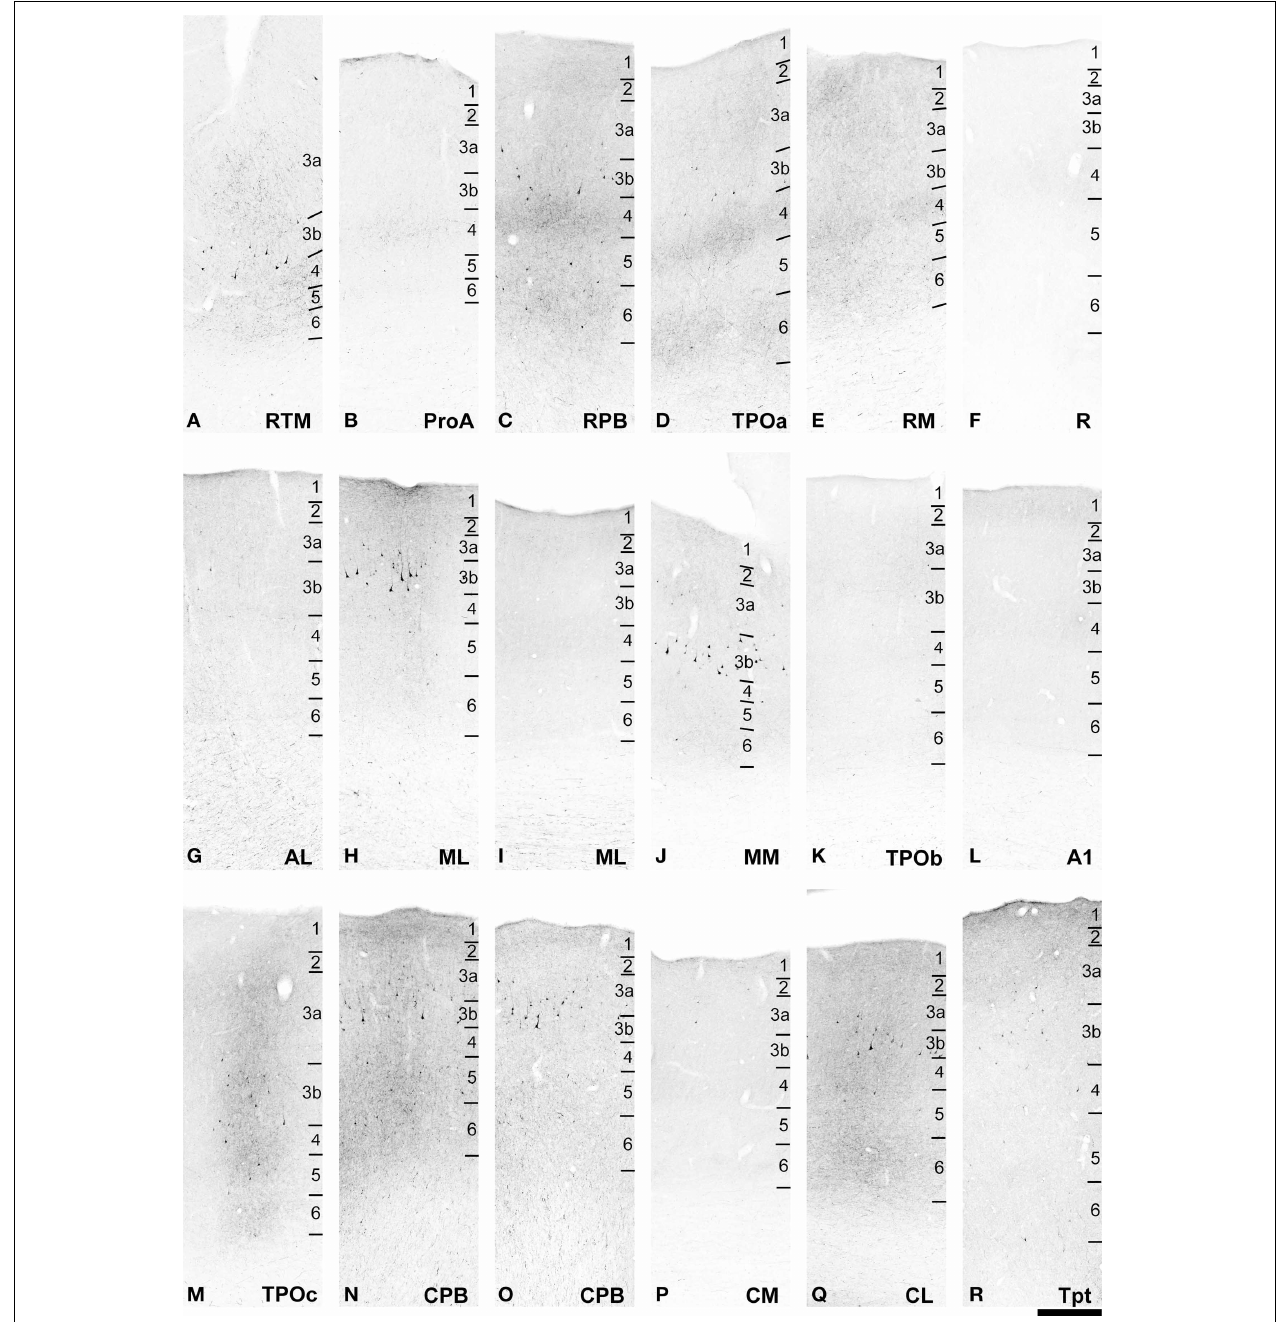
FIGURE 7 | BDA labeling of areas corresponding to rectangular selections in Figure 6. (A–J) from (A–H) in Figure 6 . (K–R) from (I–P) in Figure 6 . See text for detailed descriptions and Figure 10 for graphical summary of these data. Scale, 500 µ m.